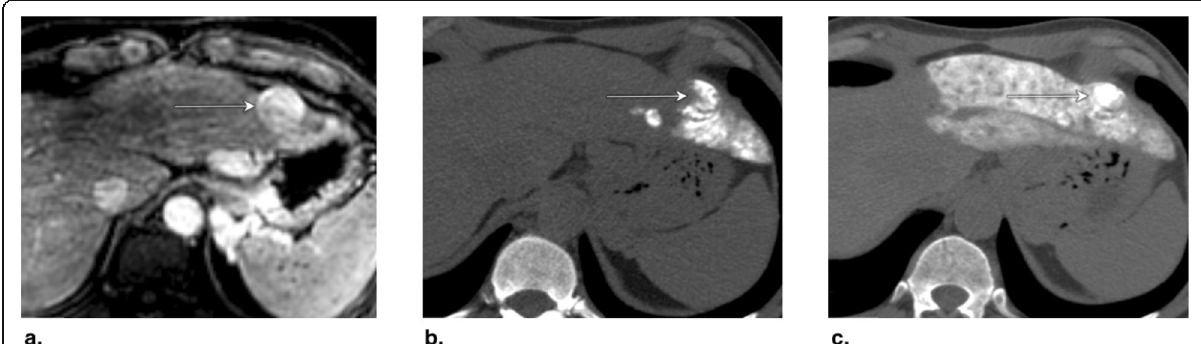
Fig. 21 a Axial T1-weighted MR in late arterial phase (AP) obtained pretreatment: image shows nonrim arterial phase hyperenhancement (APHE) of a 3-cm LR-5 observation in segments II-III (arrow). b Unenhanced axial CT obtained immediately post transarterial chemoembolization (TACE) of segment III: image shows suboptimal targeting with incomplete ethiodized oil retention (arrow). c Unenhanced axial CT obtained post repeat TACE: image shows extended treatment area with optimal targeting (arrow). Postcontrast imaging (not shown) did not show APHE or washout,